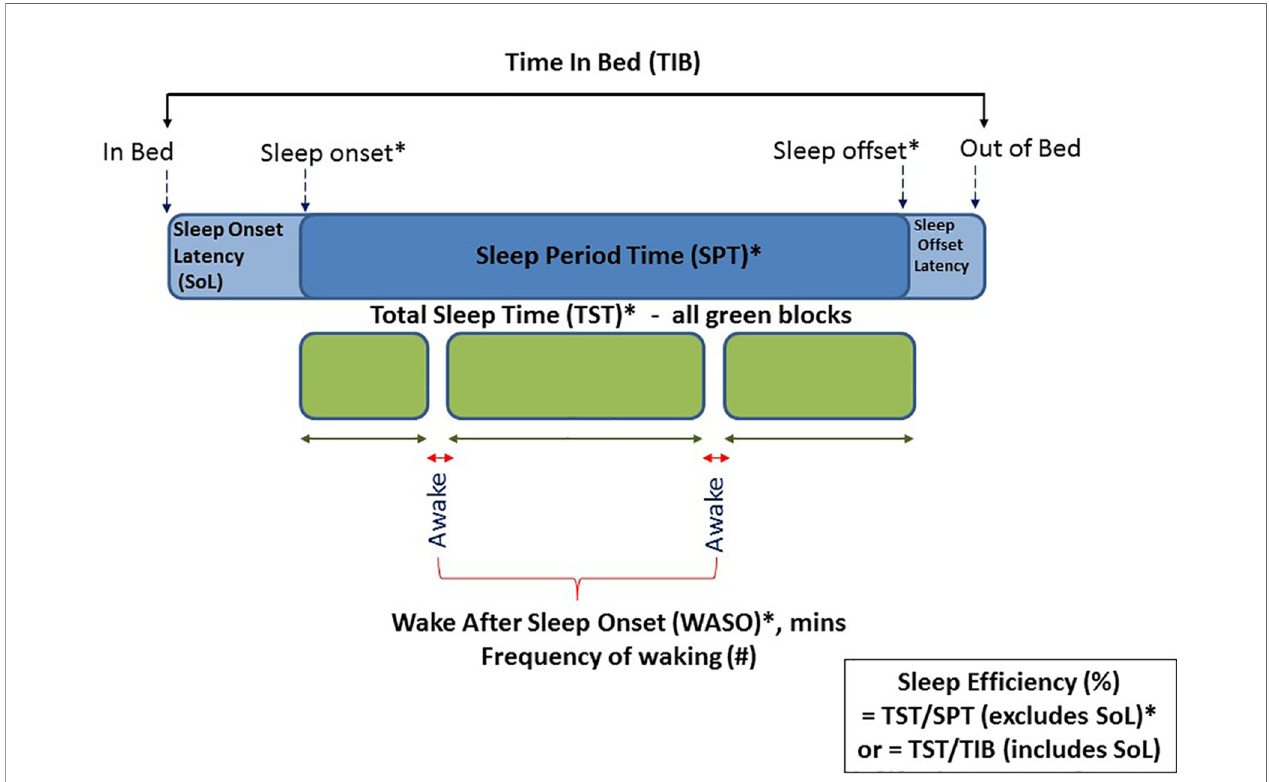
FIGURE 2 | Schematic diagram of actigraphy and PSG data extracted across the night of sleep. Those marked with an asterisk were variables included in this validation